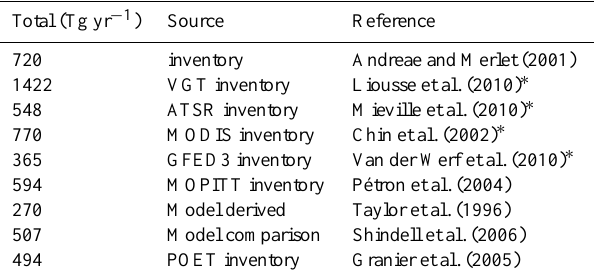
Table 5. Estimated CO emission totals from biomass burning in Tgyr − 1 . * Totals reported following the analysis of Stroppiana et al.